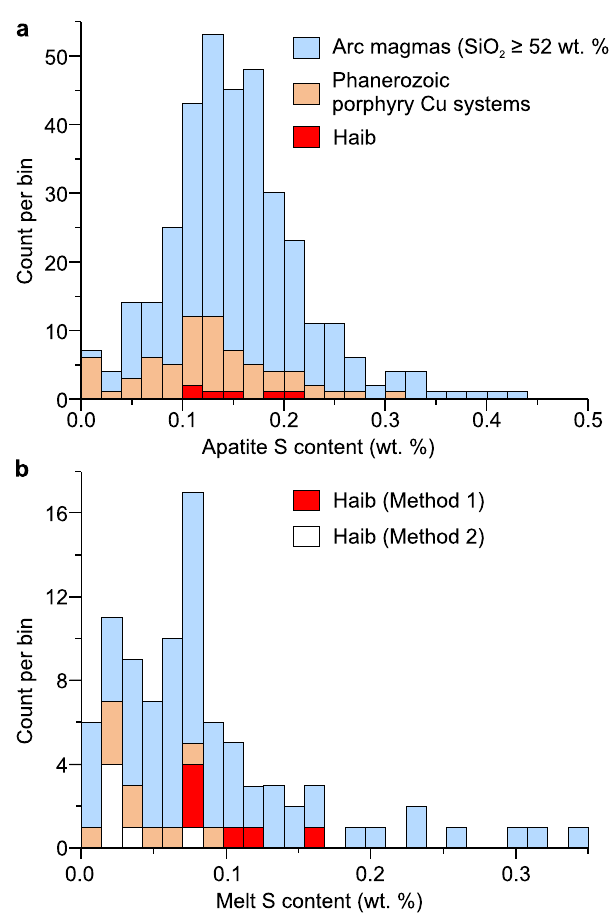
Fig. 5 Histograms of S concentrations of igneous apatites and melt inclusions from arc magmas, rocks associated with Phanerozoic porphyry Cu systems and the Haib. a Igneous apatites from intermediate to felsic arc magmas (0.15 ± 0.07 wt.% S on average; 1 σ , n = 349, basaltic-andesitic to rhyolitic composition with SiO 2 presumably ≥ 52 wt.%; most of them are from the Circum-Paci fi c volcanic arcs) and a subset from those associated with Phanerozoic porphyry Cu systems (0.12 ± 0.065 wt.% S on average; 1 σ , n = 64) and Haib ( n = 6). b Measured S concentrations of melt inclusions in olivine and minor pyroxene in arc rocks (0.09 ± 0.07 wt.% on average; 1 σ , n = 69; SiO 2 ≥ 52 wt.%; data from GEOROC database) and in rocks associated with Phanerozoic porphyry Cu systems, as well as those estimated using apatite-melt partition coef fi cients for S from the Haib igneous apatites. The melt inclusion data for arc rocks were fi ltered using CO 2 ≥ 50 ppm to identify those with limited degassing (see ref. 86 ). N represents numbers of samples or groups of apatites and melt inclusions. See data sources in Supplementary Note